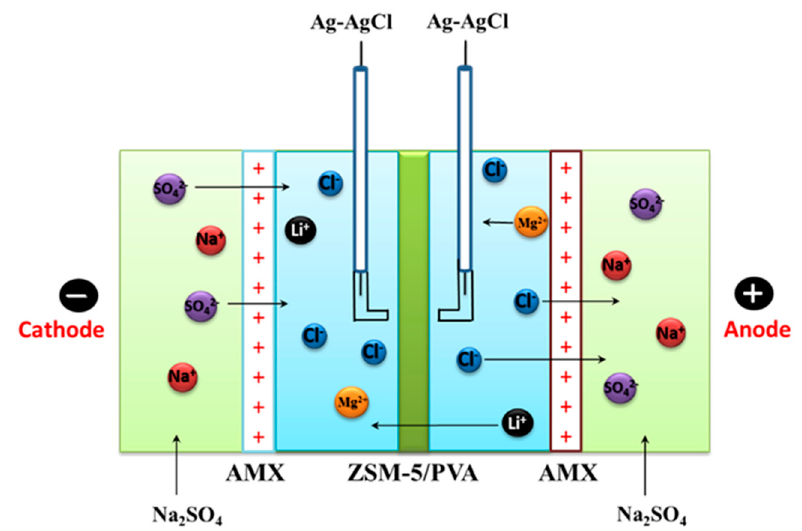
Figure 1. Schematic diagram of the testing device for the I–V curve.